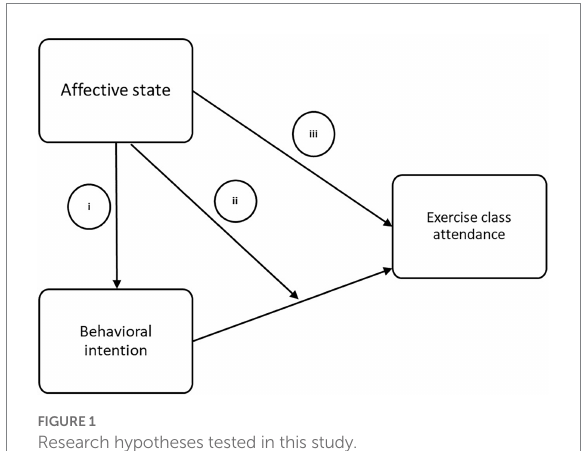
FIGURE 1 Research hypotheses tested in this